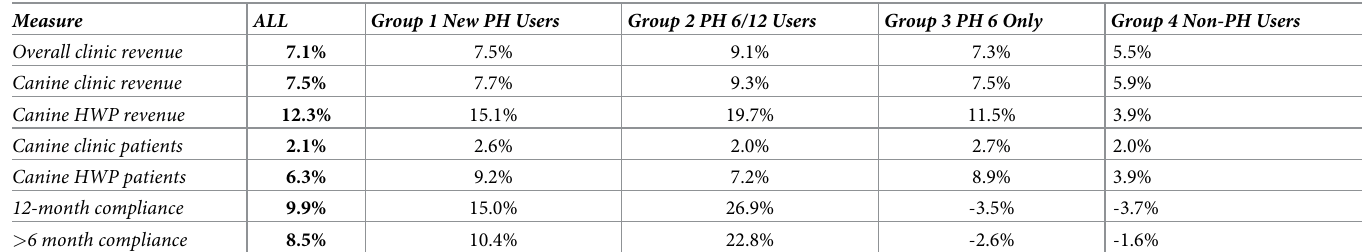
Table 11. Summary of year over year growth or decline for all